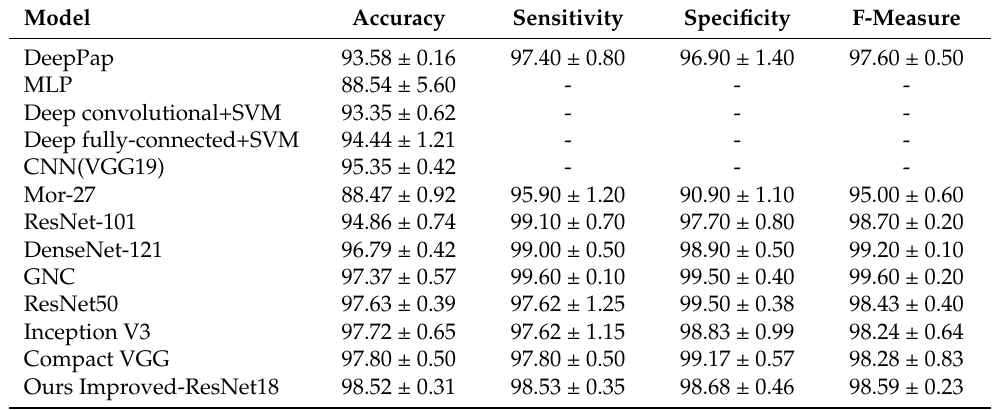
Table 2. The accuracy of the proposed method compared with other methods using SIPaKMeD. Model Accuracy Sensitivity Specificity F-Measure DeepPap